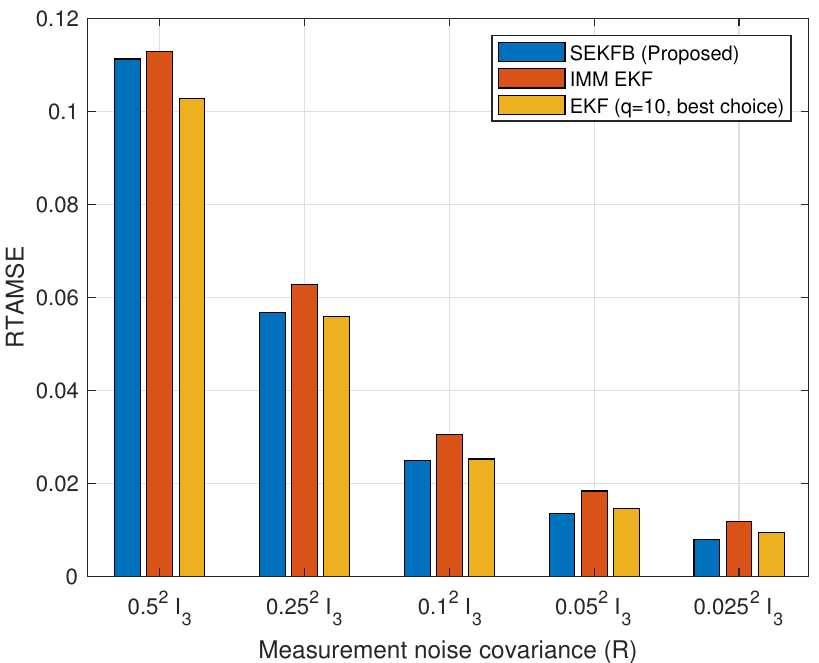
Figure 6. Root time-averaged mean square error under various measurement-noise